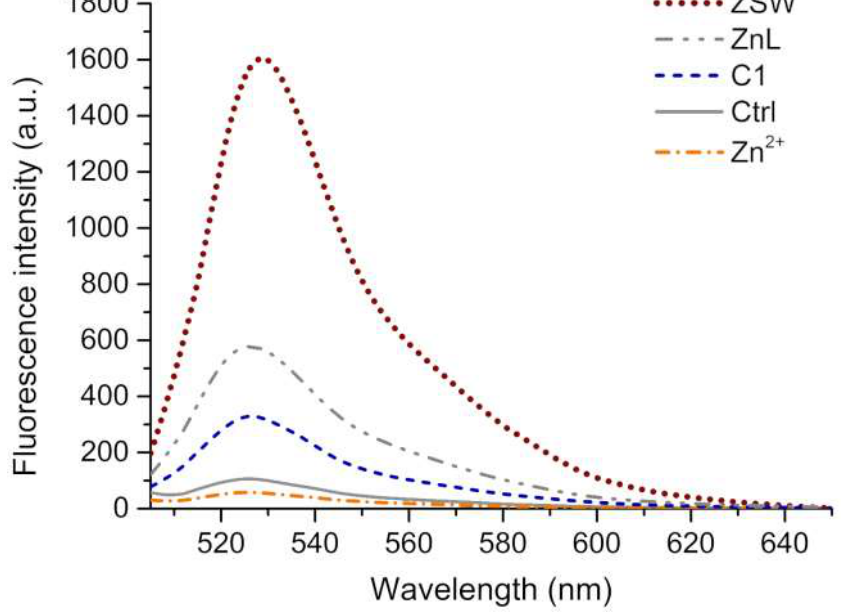
Figure 5. The intensity of the fluorescence of DCF ( λ ex = 485 nm, λ em = 650 nm) in pH 7.4 Tris-buffer (20 mM Tris-HCl/150 mM NaCl) induced by ZSW (0.025 mM), K 4 [SiW 12 O 40 ] (C1, 0.025 mM), ZnCl 2 (Zn 2+ , 0.025 mM), ZnL (Zn 2+ + Cyclen, 0.025 mM), and the control group samples. The Gaussian 09 package was used to perform the optimization and frequency com- putational calculations at the DFT B3LYP/Lanl2dz level [44]. Frontier molecular orbitals represent an invaluable method for analyzing the electric characteristics of coordination compounds. The selected electron-occupied (HOMO) and -unoccupied (LUMO) MOs for [Zn 2 (4,4 (cid:48) -bpy)(Phen) 2 ] 4+ and the Keggin-type [SiW 12 O 40 ] 4– cluster are shown with energy values in Figure 6AB, respectively. For [Zn 2 (4,4 (cid:48) -bpy)(Phen) 2 ] 4+ , the electron clouds of the HOMO were distributed on the molecular skeleton of the aromatic ring at both ends. Those of the LUMO were homogeneously well-distributed on the molecular skeleton. As for the [SiW 12 O 40 ] 4– cluster, the electron clouds in the HOMO were mainly accumulated in the molecular center; however, in case of the LUMO, the function groups on the outer molecular layer contributed to the electron cloud of the LUMO. As also shown in Figure 6, the values of the ∆ E (E LUMO –E HOMO ) for [Zn 2 (4,4 (cid:48) -bpy)(Phen) 2 ] 4+ (A) and [SiW 12 O 40 ] 4– cluster (B) were 0.01164 and 0.20083 a.u.,